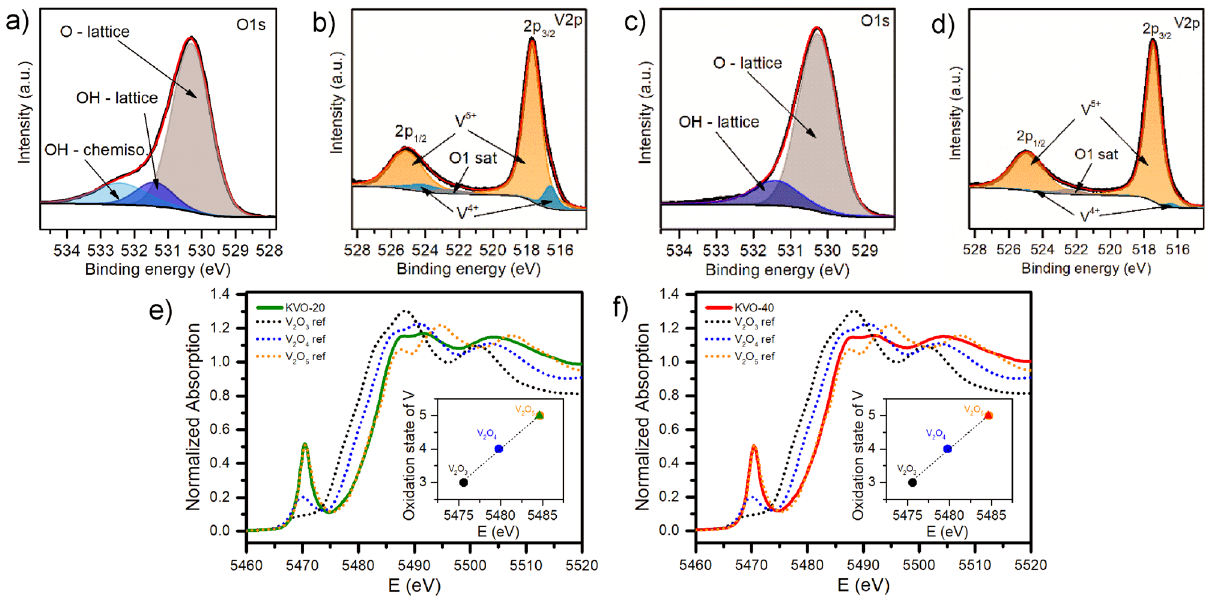
Figure 1. ( a–d ) High resolution XPS spectra of the O 1s and V 2p regions for KVO-20 ( a,b ) and KVO-40 ( c,d ), ( e,f ) V K-edge the XANES for KVO-20 ( e ) and KVO-40 ( f ), respectively (the insets show the relation between vanadium oxidation state and the edge